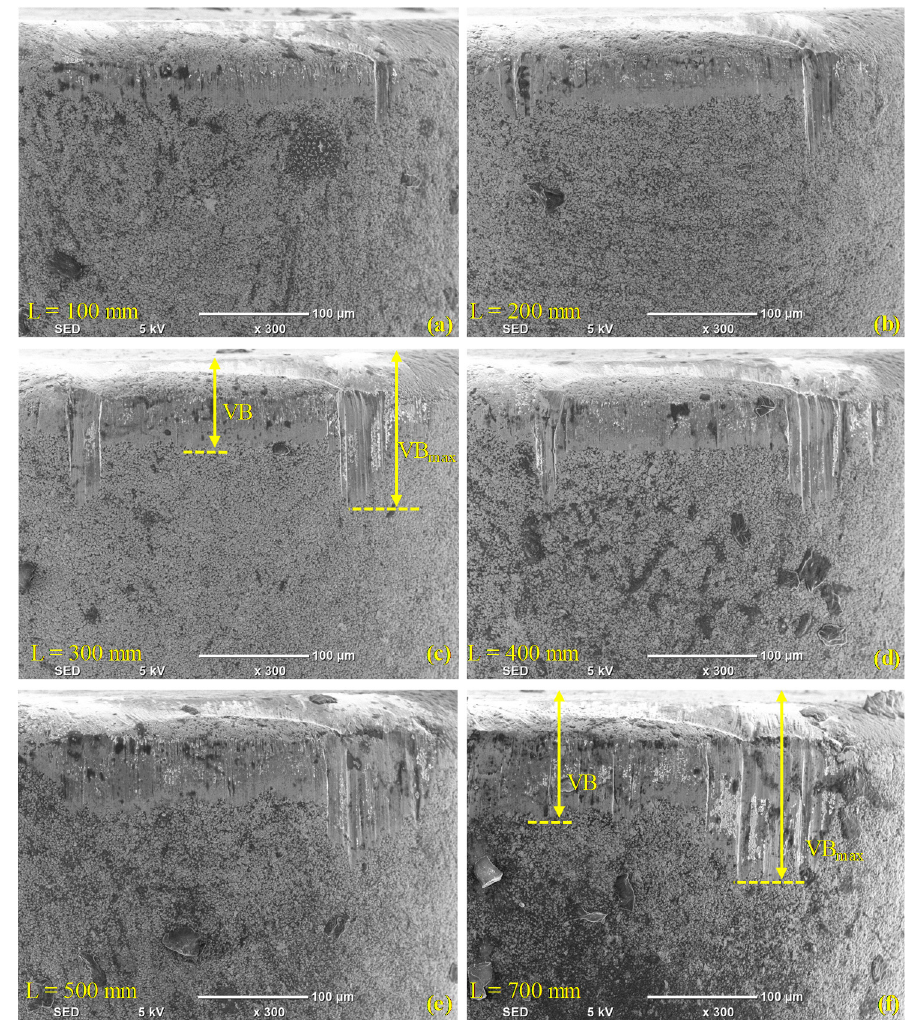
Figure 3. Flank wear in the case of conventional inserts after ( a ) L = 100 mm, ( b ) L = 200 mm, ( c ) L = 300 mm, ( d ) L = 400 mm, ( e ) L = 500 mm, and ( f ) L = 700 mm.